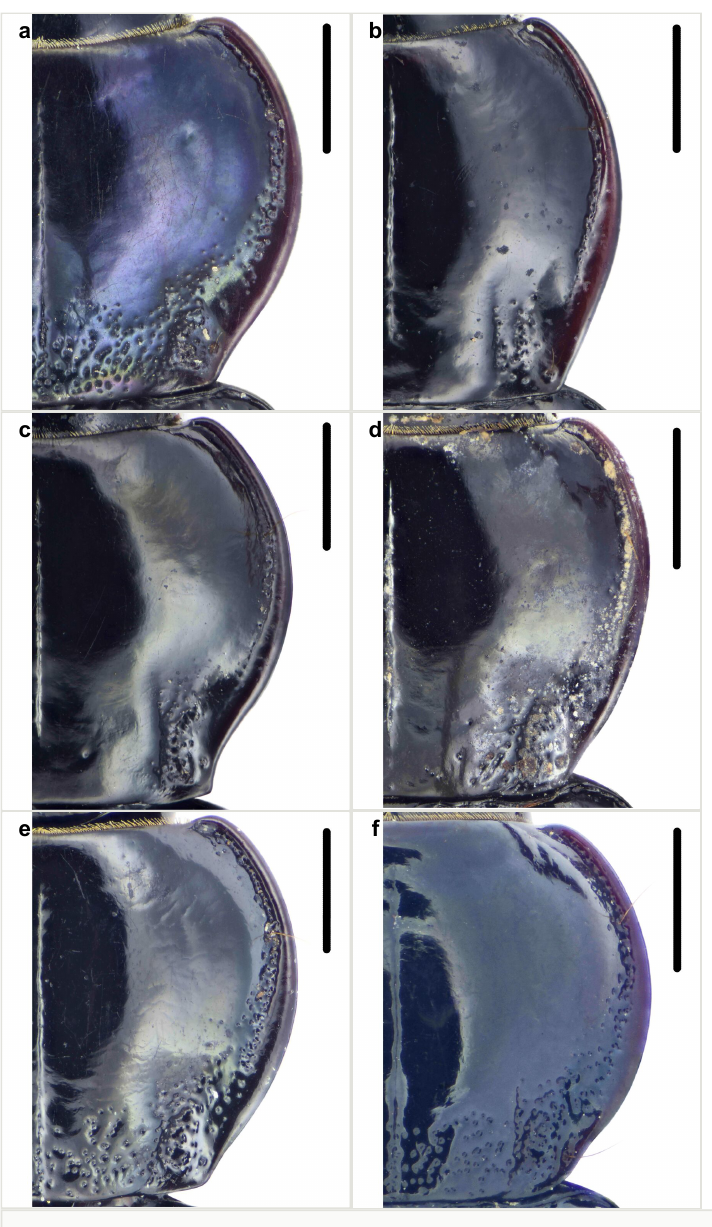
Figure 4. Pronota of Pareuryaptus spp. from China (scale bars = 1 mm): a , P. adoxus (Tschitschérine), female from Danuoyou, Yunnan; b , P. exiguus Dubault, Lassalle & Roux, male from Naqin Village, Guangxi; c , P. luangphabangensis Kirschenhofer, male from Nanpaxiaozhai, Yunnan; d , P. chalceolus formosanus (Jedli č ka), female from Jialeshui, Taiwan; e , P. chalceolus chalceolus (Bates), male from Guanyin Mt., Guangdong; f , P. chalceolus chalceolus (Bates), female from Hanjiang,